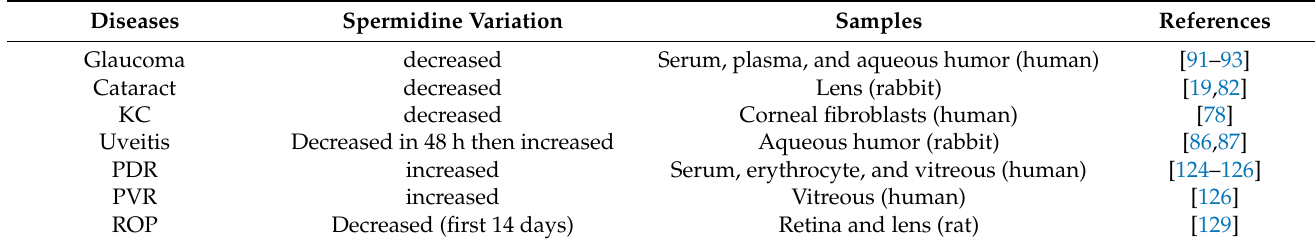
Table 1. A summary of altered levels of spermidine in ocular diseases.